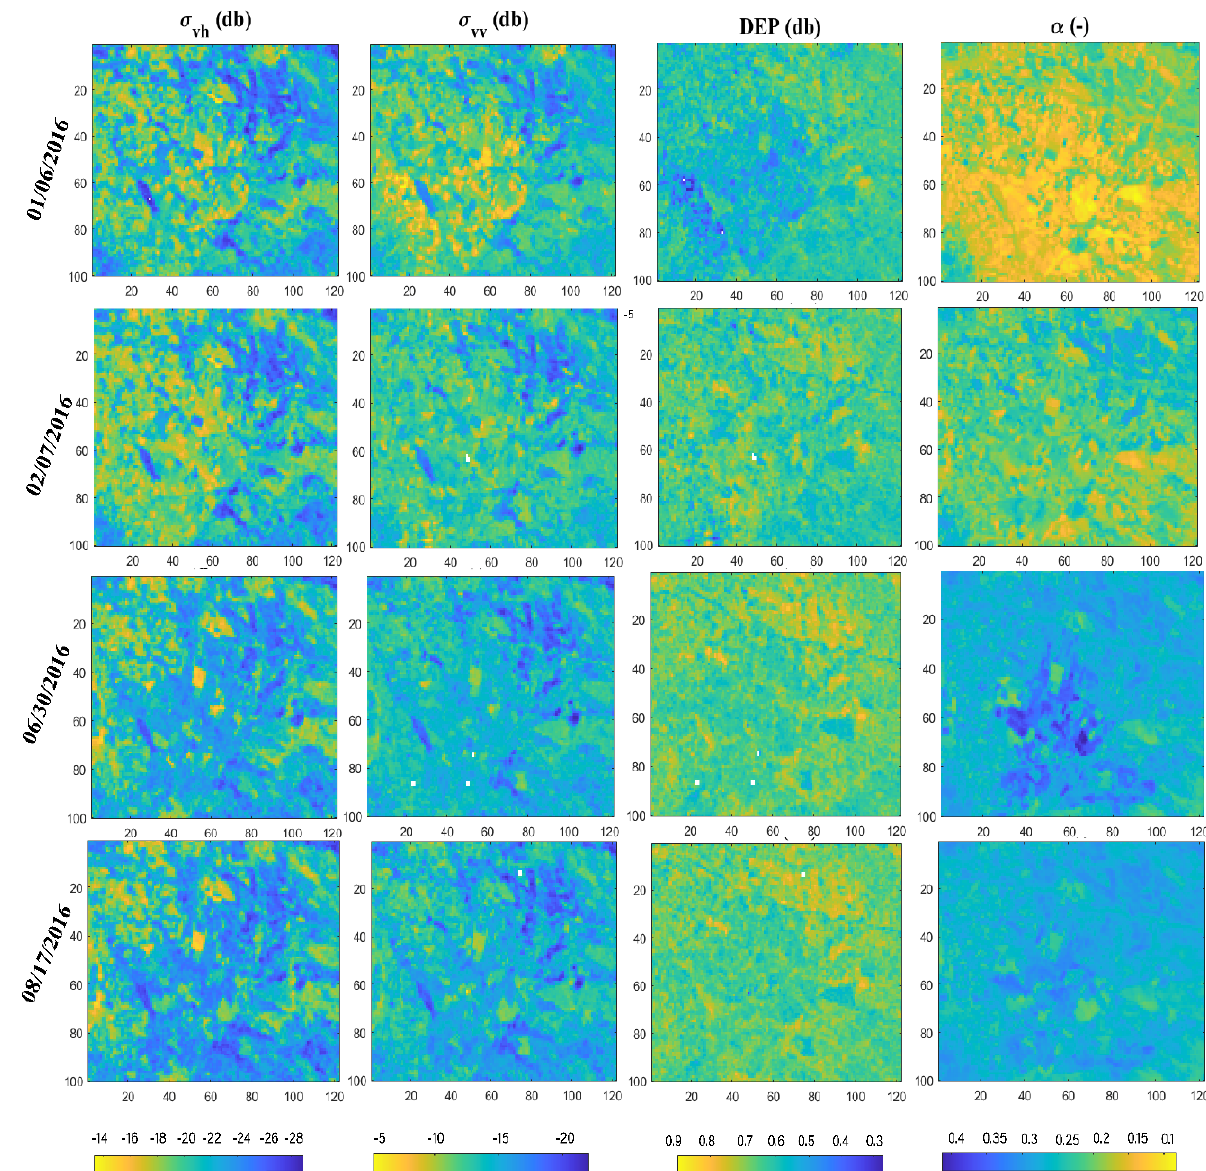
Figure 5. Images used in albedo modeling: albedo of Landsat-8 utilized as the reference feature; and backscatter coefficients VV and VH polarizations and the depolarization ratio (DEP) used as independent variables in the used approach.